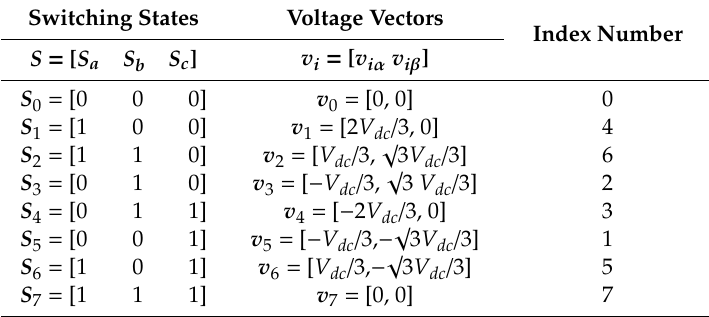
Table 2. Voltage vectors and switching states with index